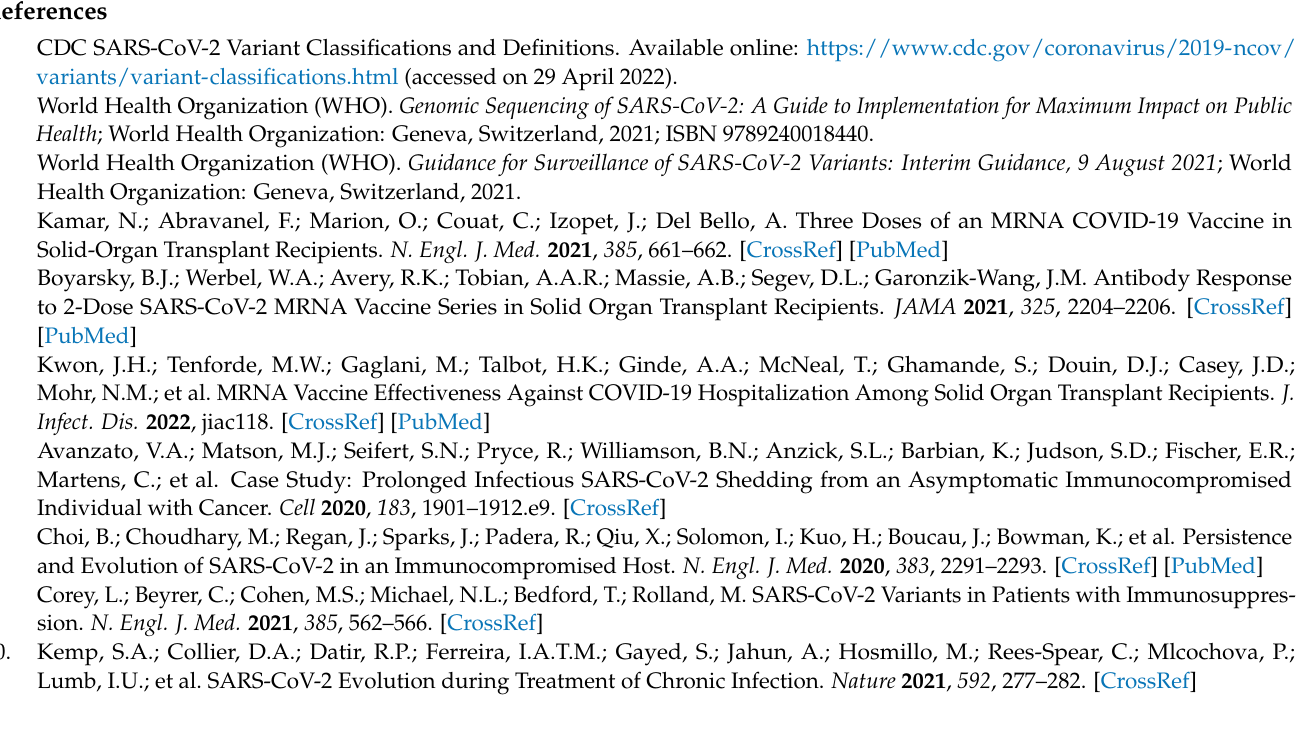
Table S1: Details of patient demographics ( n = 34), sample Ct values, and lineages.; Table S2: Private mutations identified from the 37 samples by Nextclade.; Table S3: Variant-specific mutation list used for detection of potential recombination events.; Table S4: Welch’s t -test results for comparison of silent and missense mutation frequencies in available Omicron and Delta samples